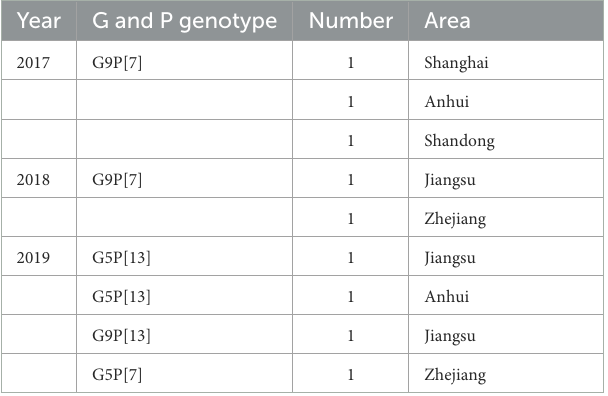
TABLE 1 Summary of genotype combinations of the sequenced